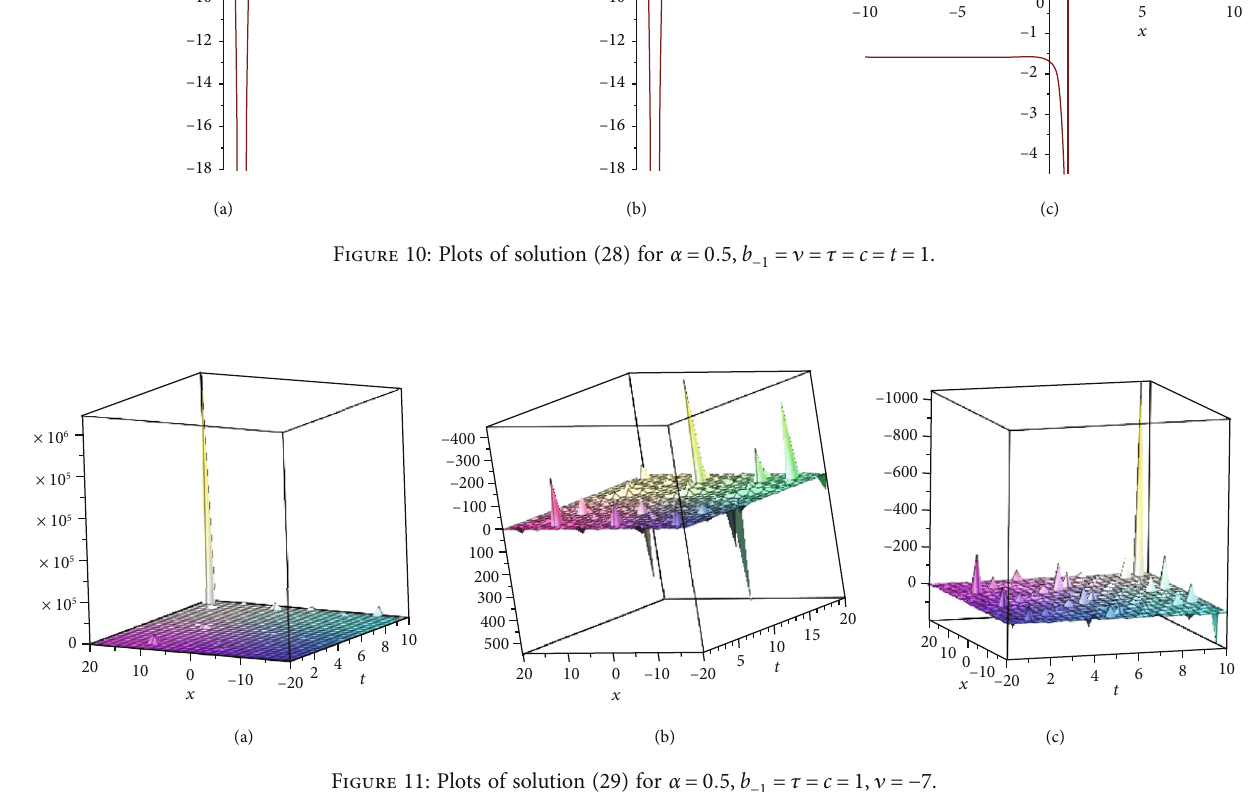
Figure 11: Plots of solution (29) for α = 0 : 5, b